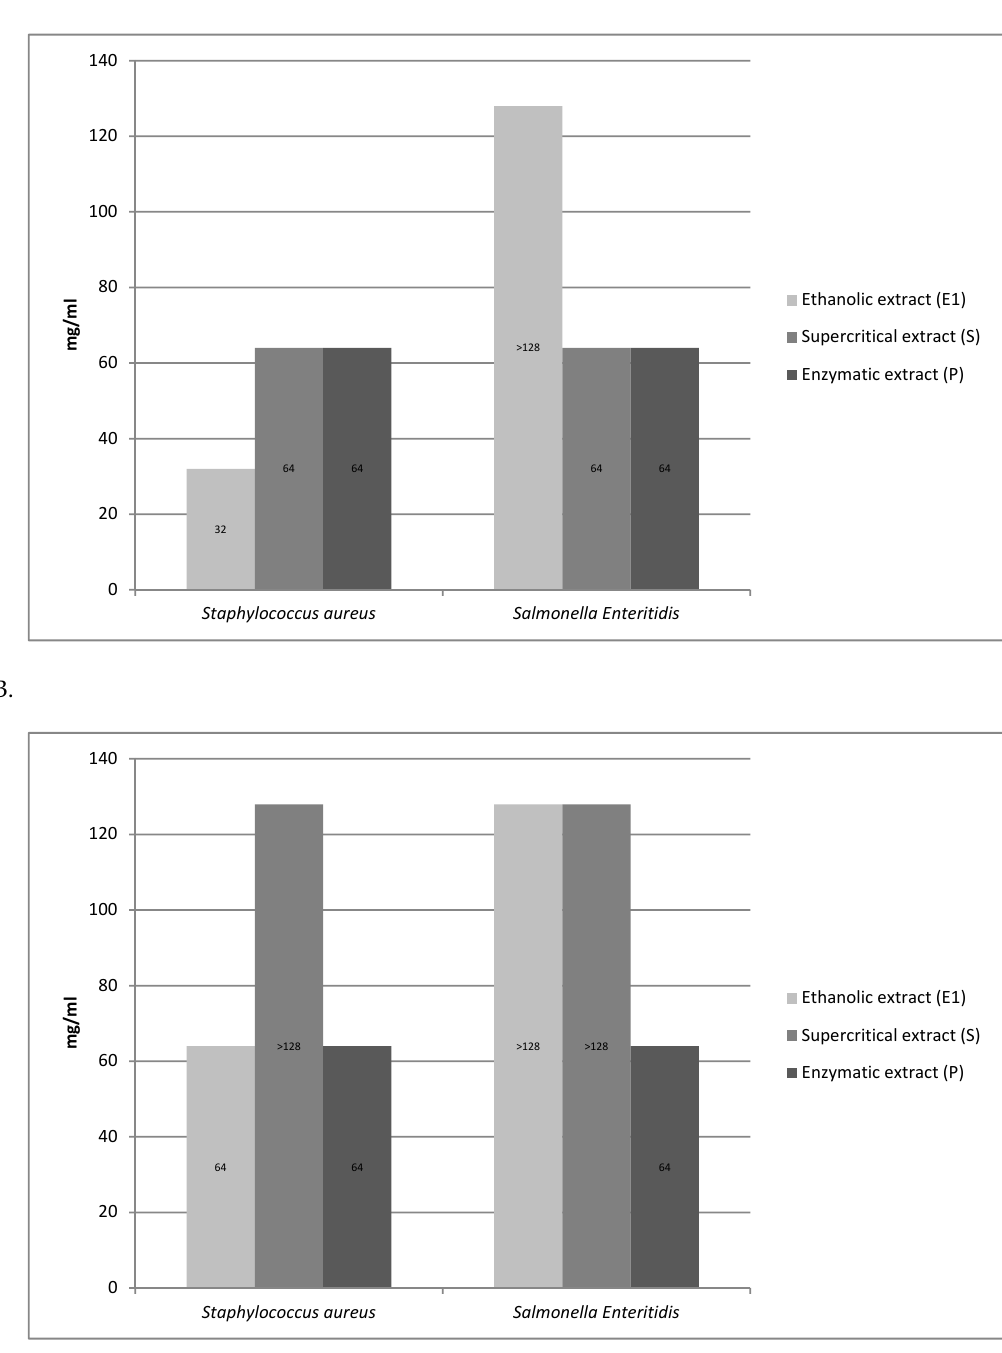
Figure 3. Comparison of the minimum inhibitory concentration (MIC) ( A ) and the minimum bactericidal concentration (MBC) ( B ) of the obtained extracts (E1, S, P) against selected Gram-positive and Gram-negative bacterial test strains.